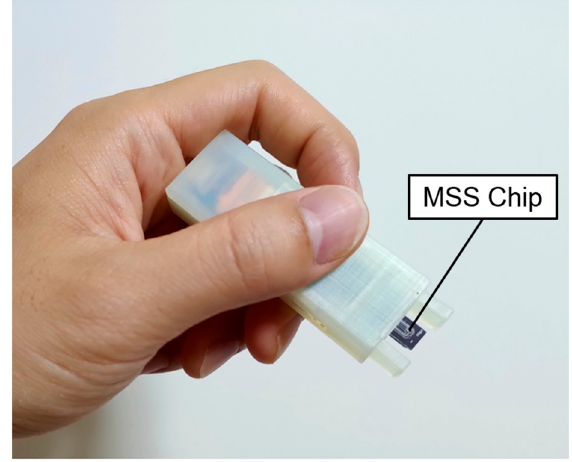
Figure 1. Picture of wireless measurement device for the free-hand measurement.